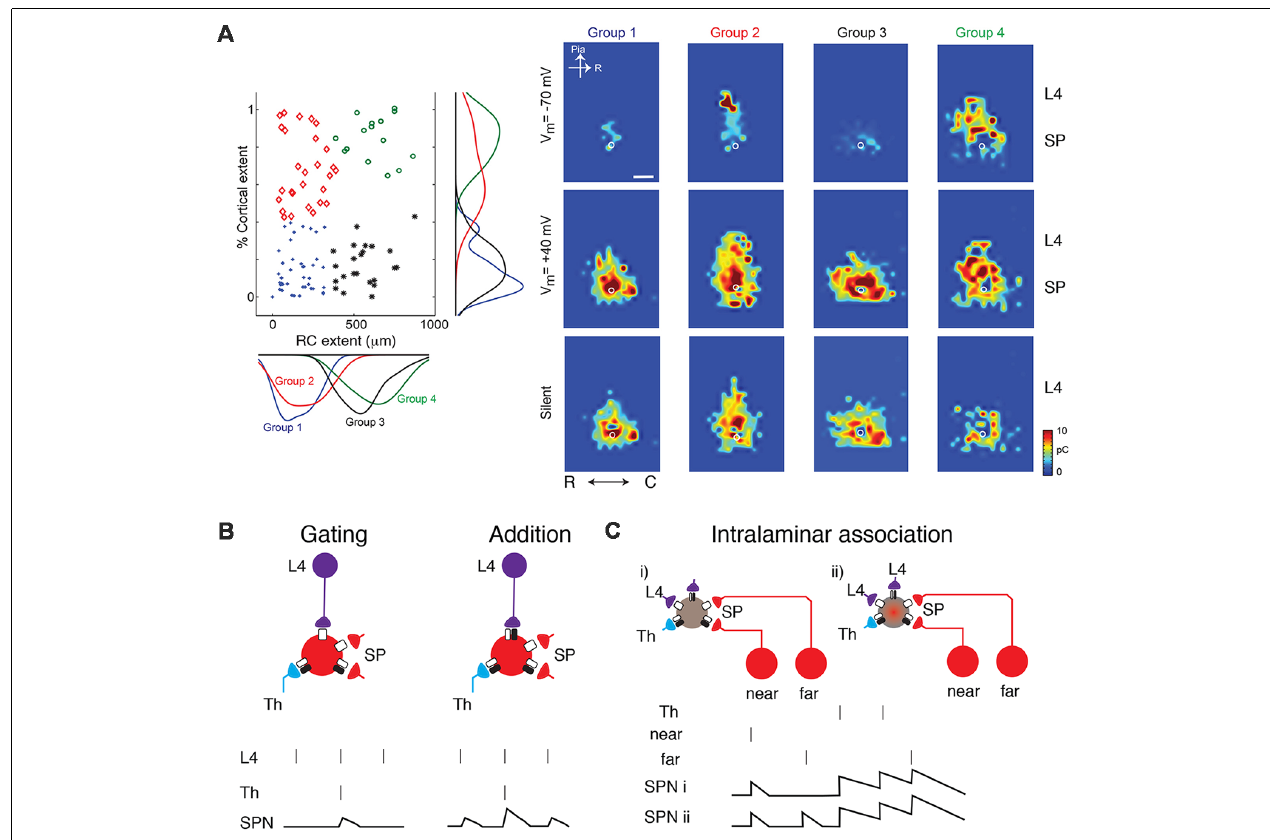
FIGURE 2 | (A) SPNs can be classified into four groups based on their inputs from L4 (from Meng et al., 2014; no copyright permission as required for use of this image). Some classes show silent or AMPAR-containing inputs from L4 while others broadly integrate within the subplate (e.g., group 3). (B) Cartoon illustration how the changing presence of silent synapses on L4 inputs can change the functional association between thalamic inputs and L4 inputs. Vertical bars indicate presynaptic spikes and SPN membrane potential indicated below. At young ages, thalamic inputs might gate L4 inputs such that an SPN depolarization is only present when both thalamic and L4 activity occurs. At older aged SPN depolarizations occur when either is active and inputs sum. (C) Silent synapses might enable the conditional association of inputs e.g., from different locations within the same